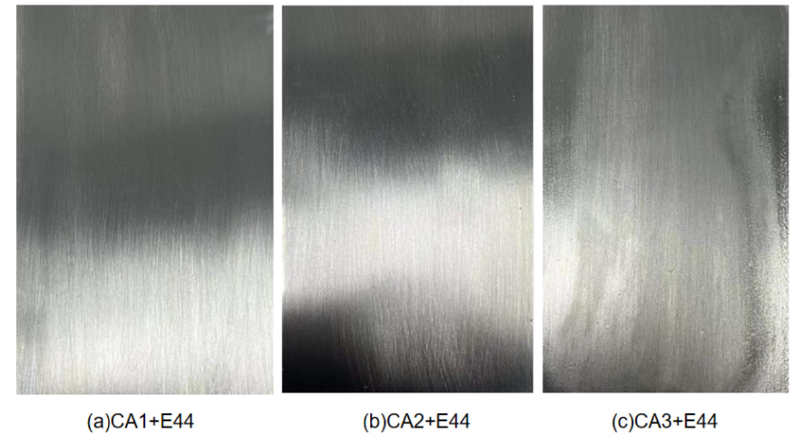
Figure 10. Coating surface of E44 cured with CA1 ( a ), CA2 ( b ), CA3 ( c ). Table 7. Coating properties of E44 cured with different curing